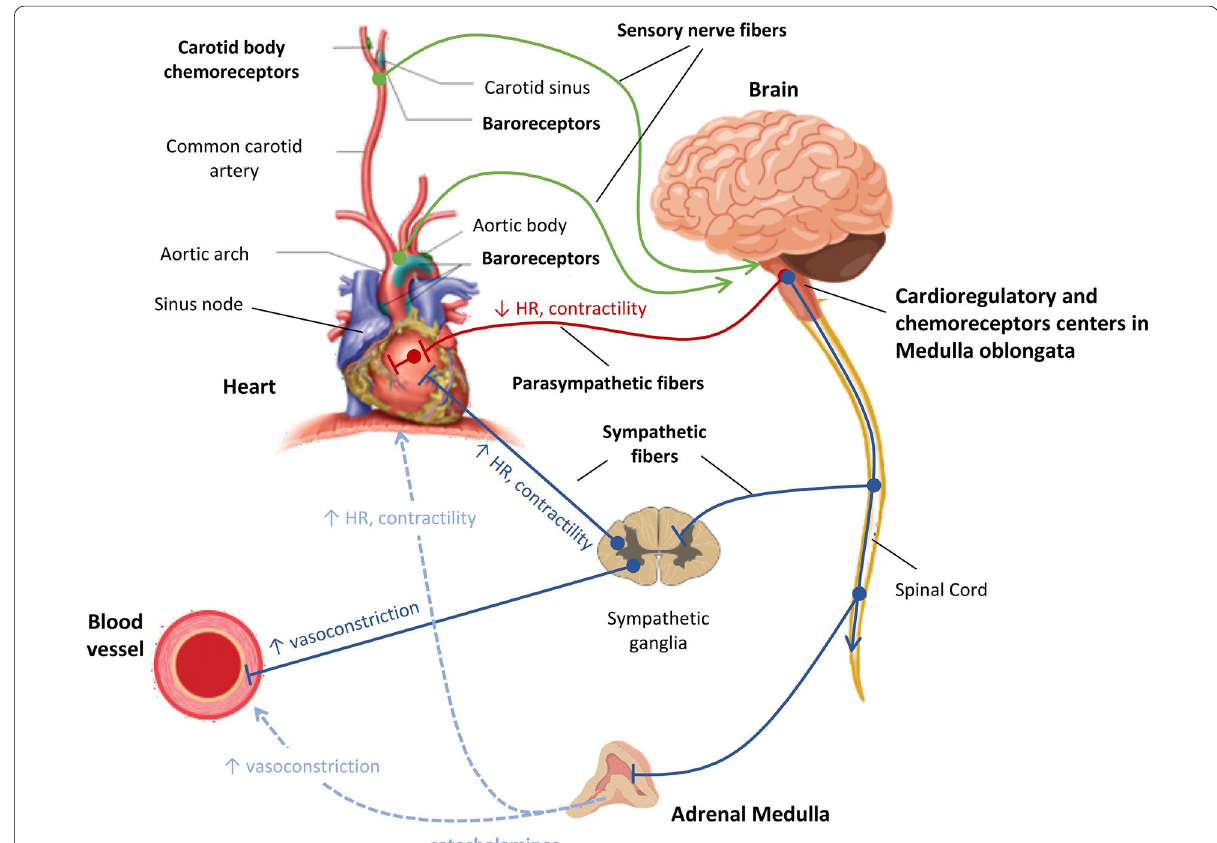
Fig. 1 Illustration of the short-term ANS regulatory mechanisms of the cardiovascular system. The arterial baroreceptors, usually known as high-pressure baroreceptors, are mainly located in the aortic arch and carotid sinuses. Cardiopulmonary baroreceptors—also known as volume-receptors or low-pressure baroreceptors—are located in the atria, ventricles, vena cava, and pulmonary vessels. The chemoreceptors are located both peripherally (carotid bodies and aortic arch) and centrally. The vasomotor center hosts the circulatory regulation and is part of the medulla oblongata located in the brainstem, next to the nucleus of the solitary tract that receives sensory nerves signals through the glossopharyngeal and the vagus nerves (green lines). The SNS fibers (blue lines) originate from the medulla oblongata and emerge from the spinal cord’s upper thoracic segments as pre-ganglionic neurons, ending inside the sympathetic chain ganglia located next to the vertebral column. SNS post-ganglionic neurons leave the sympathetic chain ganglia towards their target organs, namely the heart, the vessels, and the adrenal glands. Note that adrenal medulla sympathetic activation also induces epinephrine and norepinephrine release (dashed light blue lines) into the bloodstream. The PNS fibers (red lines) also originate from the brain stem and are incorporated as pre-ganglionic neurons in the vagal nerve, ending on the parasympathetic cardiac ganglia lying in the heart fat pad. Very short post-ganglionic neurons arise from these parasympathetic cardiac ganglia towards the right and left atrium, the atrioventricular node, the interatrial septum, the ascending aorta, and the pulmonary trunk. During septic shock, hypotension and the inflammatory reaction inhibit the vagal centers—inducing vagal outflow reduction—whereas the sympathetic pathway is stimulated. Sepsis, therefore, provokes a striking imbalance in ANS activity with a shift towards the